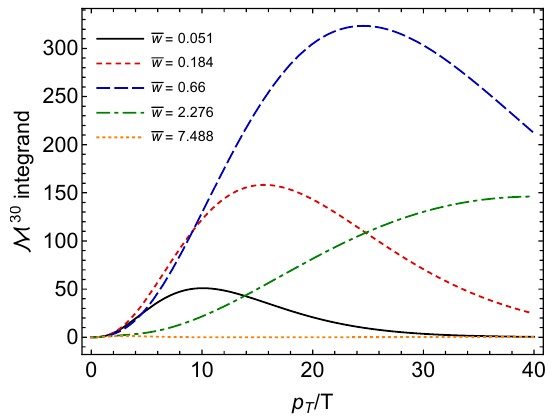
Figure 4 . Integrand of the M 30 moment obtained from the exact attractor solution as a function of p T =T with p z = 0. The di(cid:11)erent lines show di(cid:11)erent values of w .